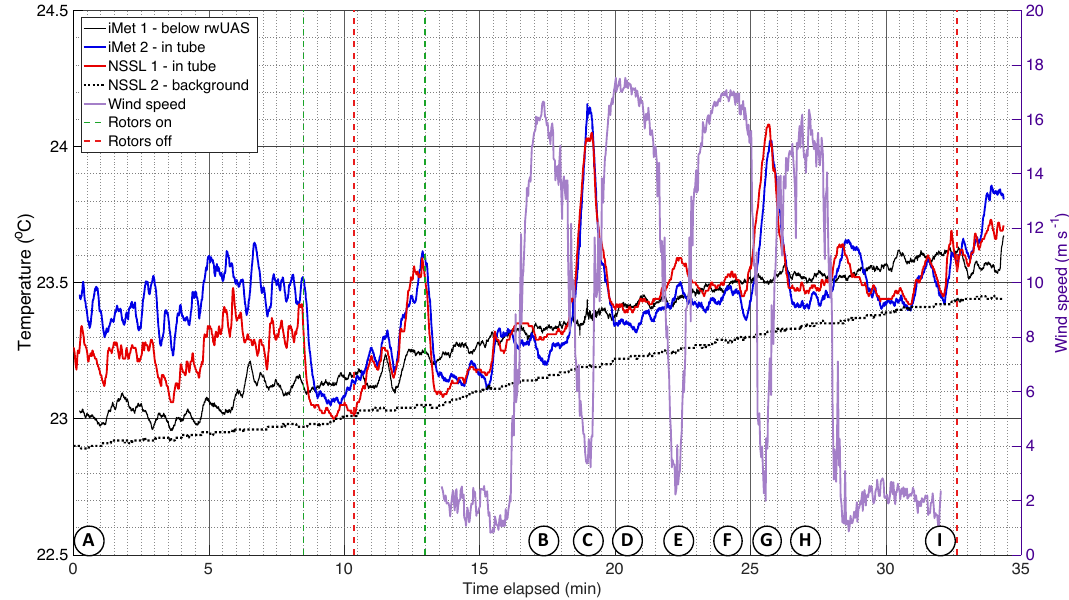
Figure 5. Experiment 1 – time series graph of air temperature ( ◦ C) and wind speed (ms − 1 ). The background temperature is shown by the CS 109 probe (dotted black) and the iMet sensor (solid black). The CopterSonde temperatures are shown by the iMet sensor (solid blue), while the reference temperature of the CS 109 is shown in solid red. Air velocity at the CopterSonde sensor location is plotted in solid orange. Dotted green and red vertical lines indicate times when the motors were throttled on and off, respectively. Points A–I from Fig. 2 are also indicated here.